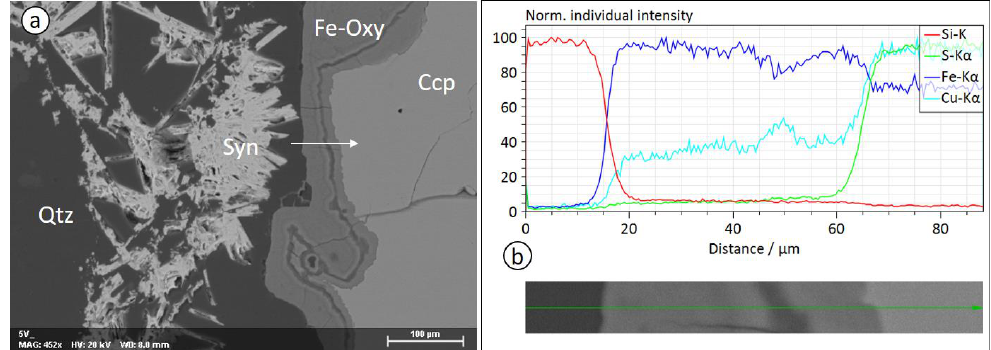
Figure 5. ( a ) Large chalcopyrite crystal (Ccp) with a Fe-Cu-oxide reaction rim. ( b ) Compositional profile along the trace evidenced in ( a ). Note that how the fine dark rim within the oxide yields a Cu/Fe ratio higher than the surrounding, which conflicts with the darker gray tone, suggesting a (Cu,Fe)-bearing material with a lower average atomic number, possibly an hydroxide.